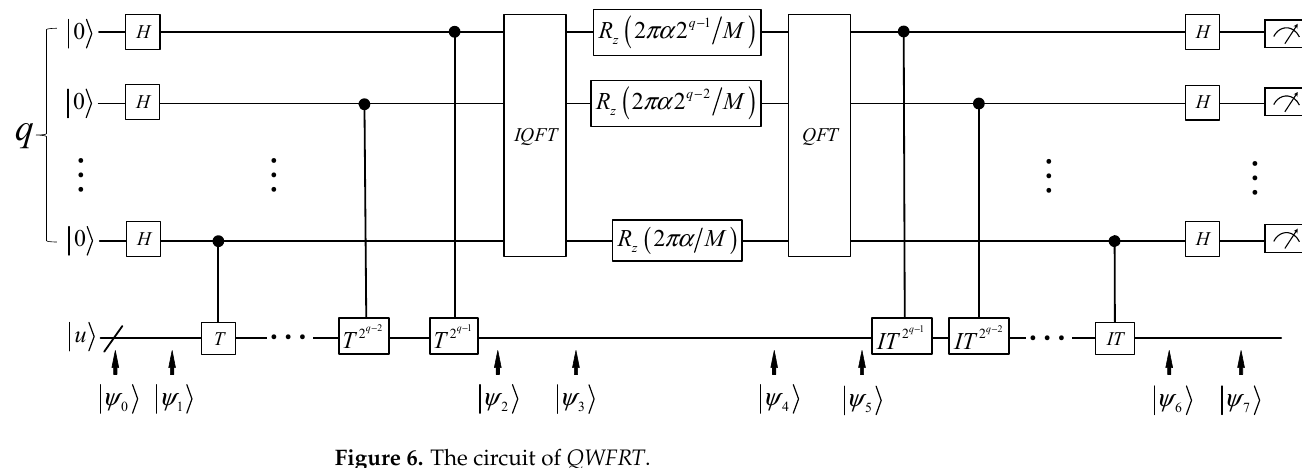
Figure 6. The circuit of QWFRT .